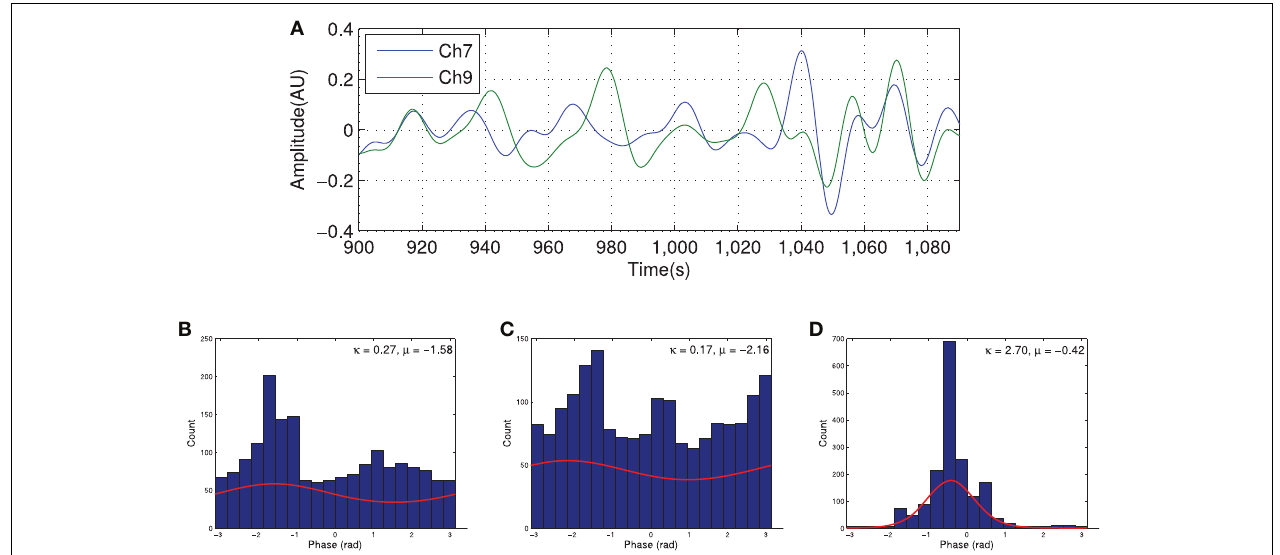
channel 9] along with the joint phase distribution (D). The red curve in histograms shows the estimated probability